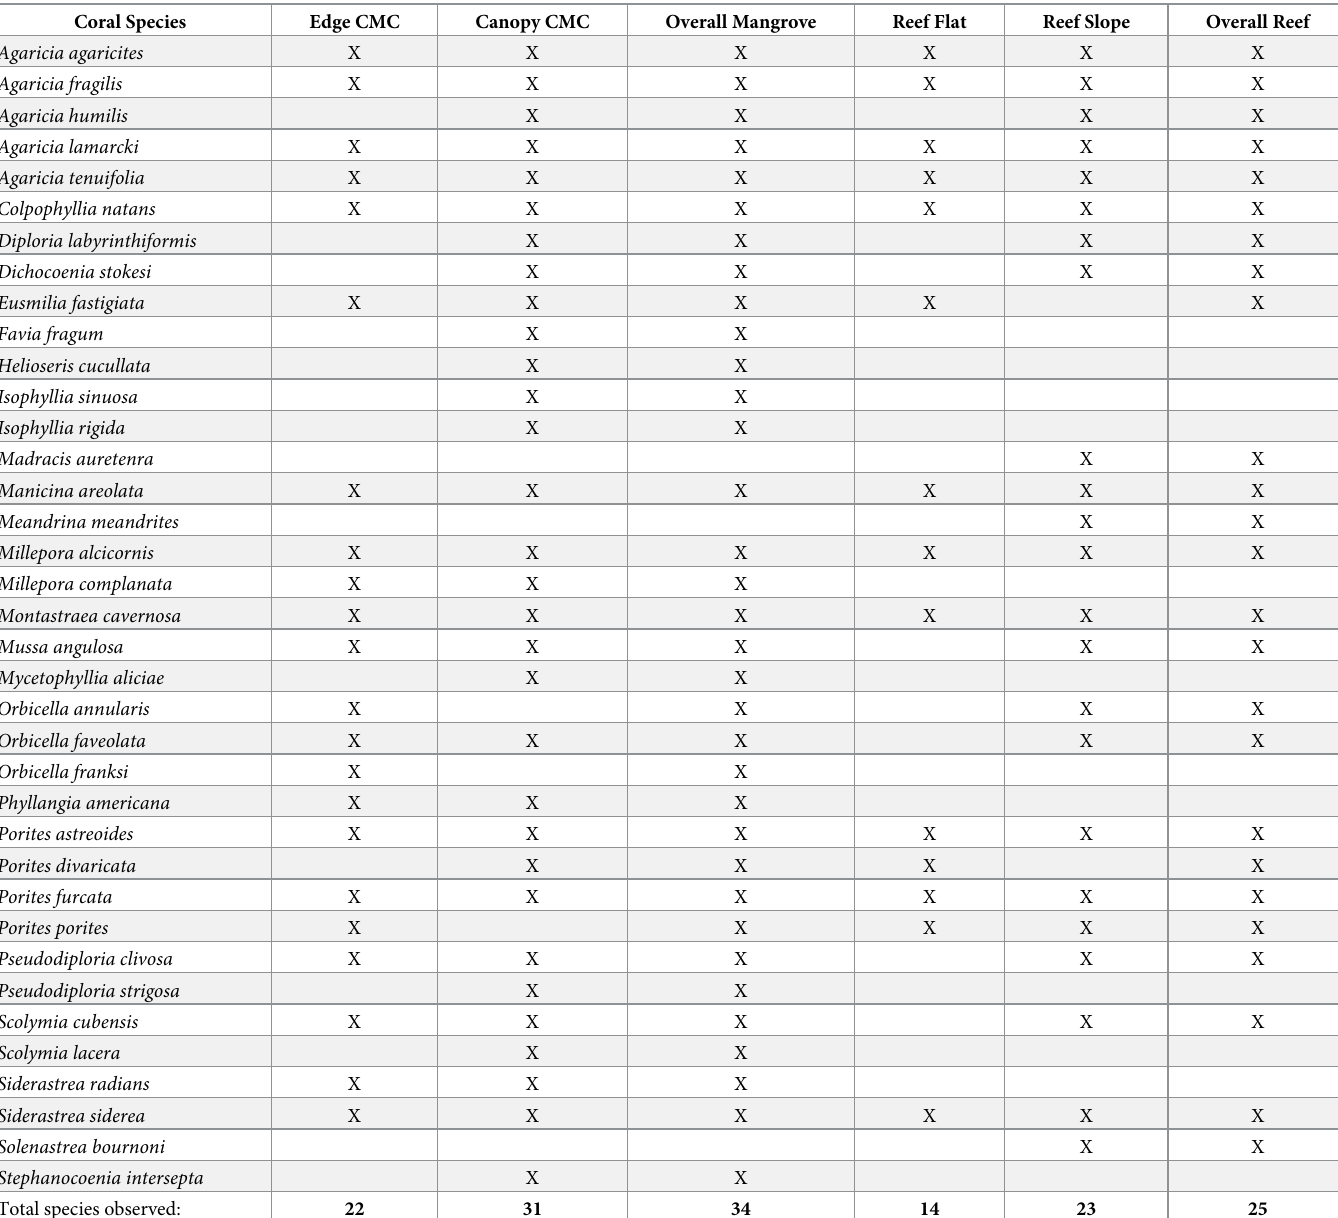
Table 2. Coral species observed growing within coexisting mangrove-coral (CMC) habitats and adjacent reef in Bocas del Toro, Panama. Coral